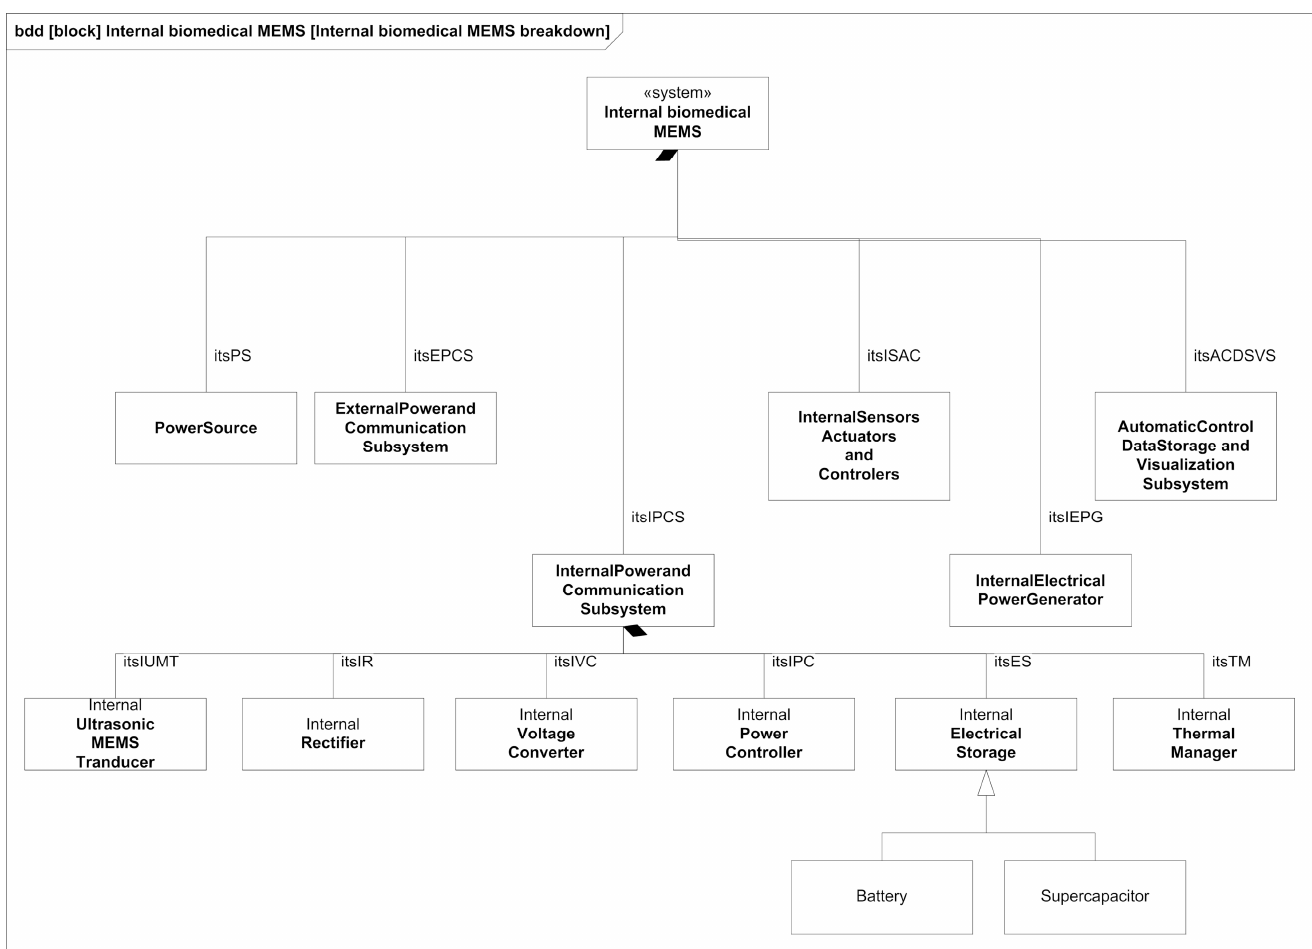
Figure 3. Refined physical architecture of the best WPT alternative (APT) after the trade-off study.